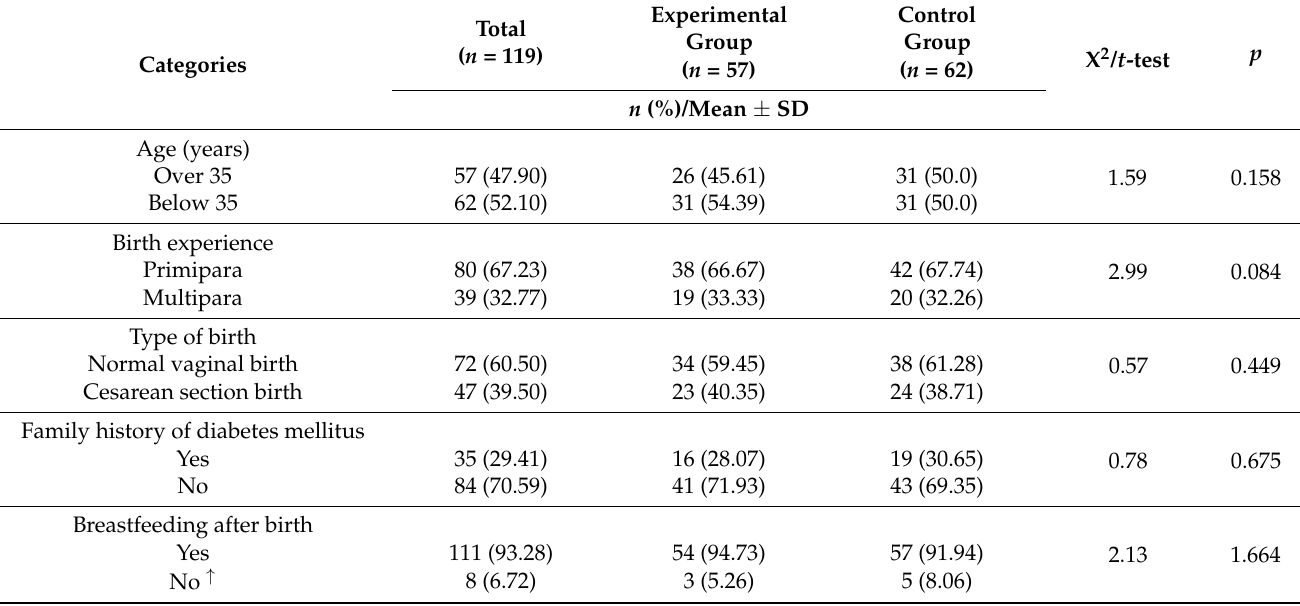
Table 1. General characteristics of the